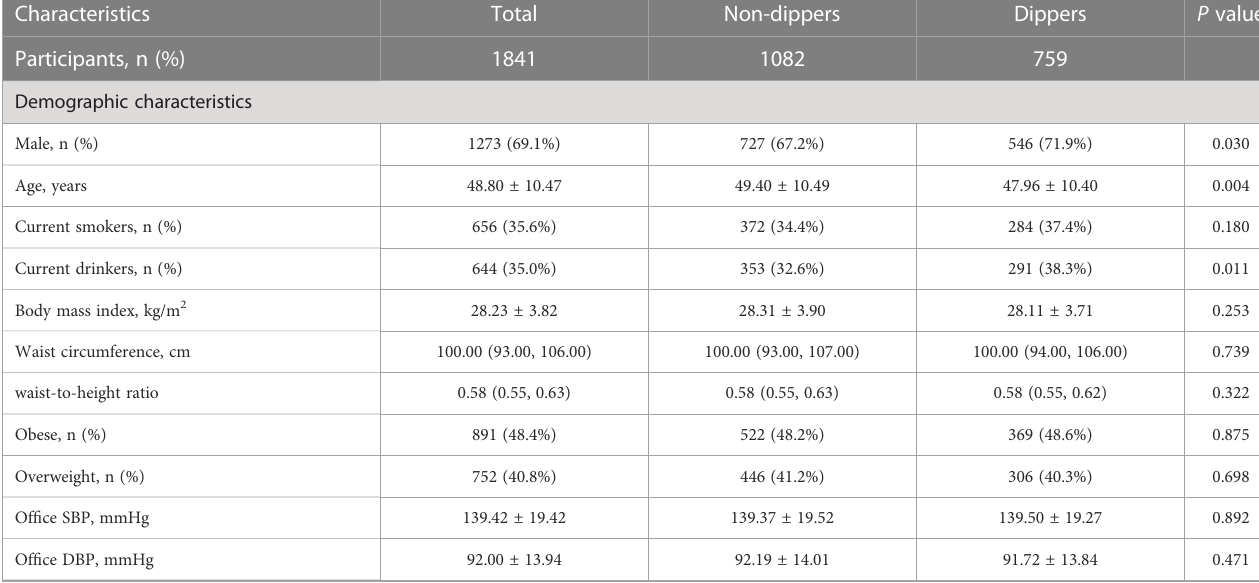
TABLE 1 Baseline characteristics for the total, non-dippers, and dippers. Characteristics Total Non-dippers